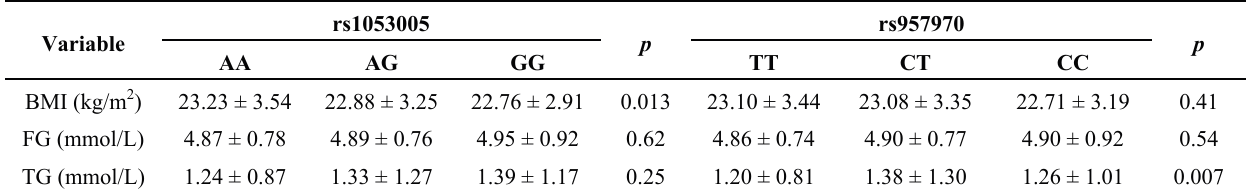
Table 2. The associations between signal transducer and activator of transcription 3 ( STAT3 ) polymorphisms and body mass index (BMI) or serum indices a . Variable